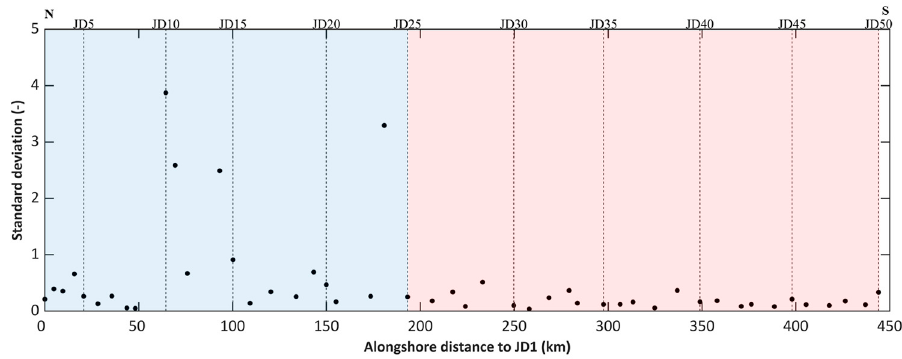
Figure 14. Standard deviation of three intertidal beach slopes calculated with different boundaries.